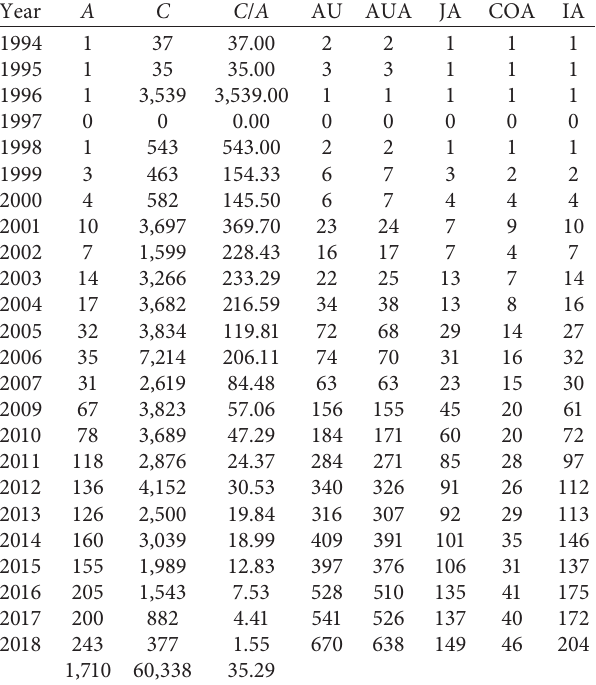
Table 2: Main characteristics of the data